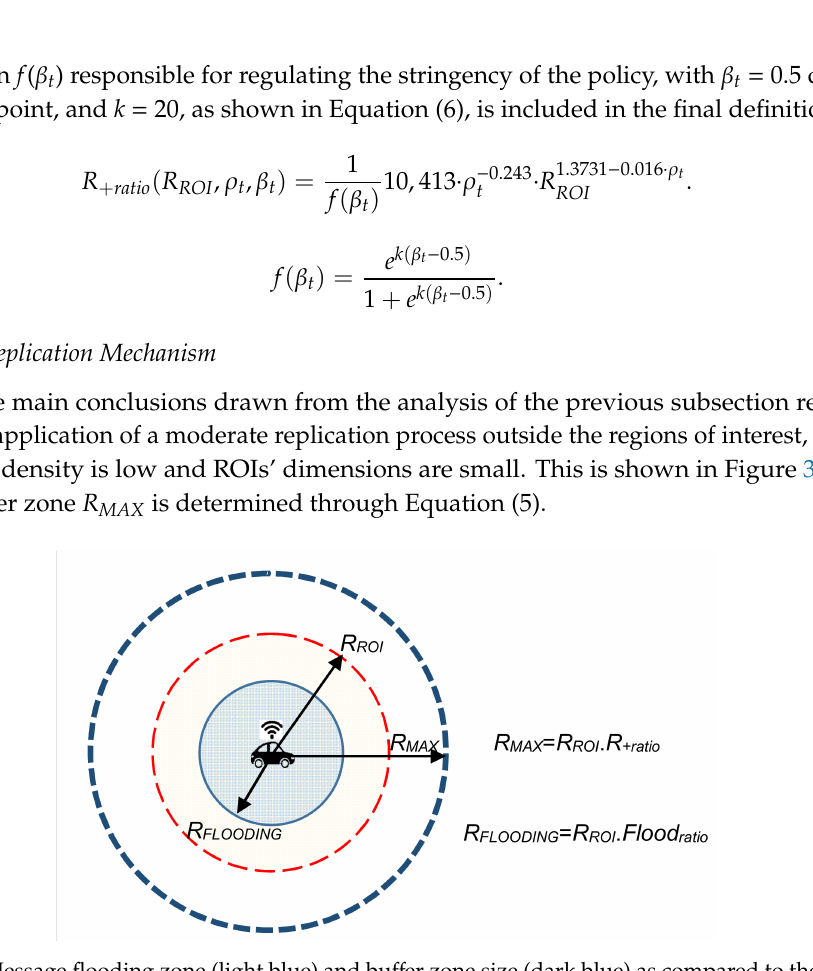
Figure 3. Message flooding zone (light blue) and bu ff er zone size (dark blue) as compared to the size of the ROI